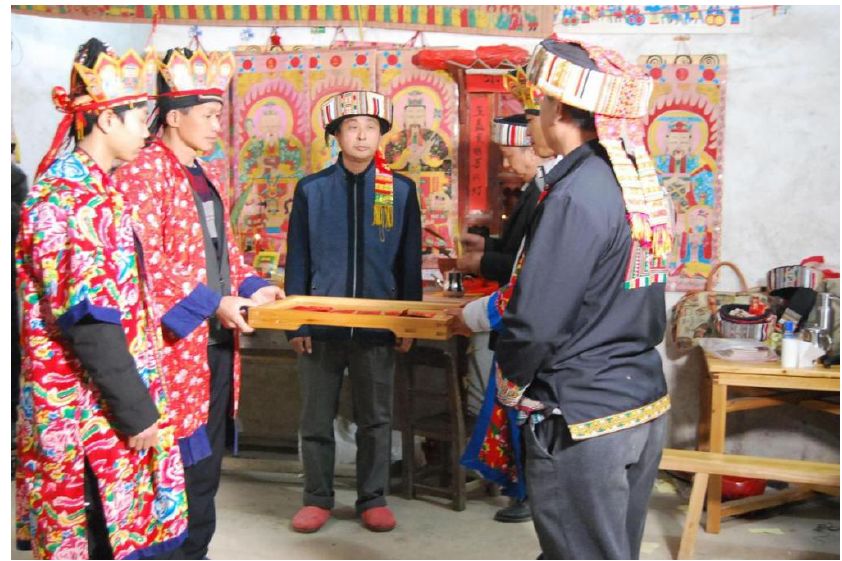
Figure 6. Blessing from the masters